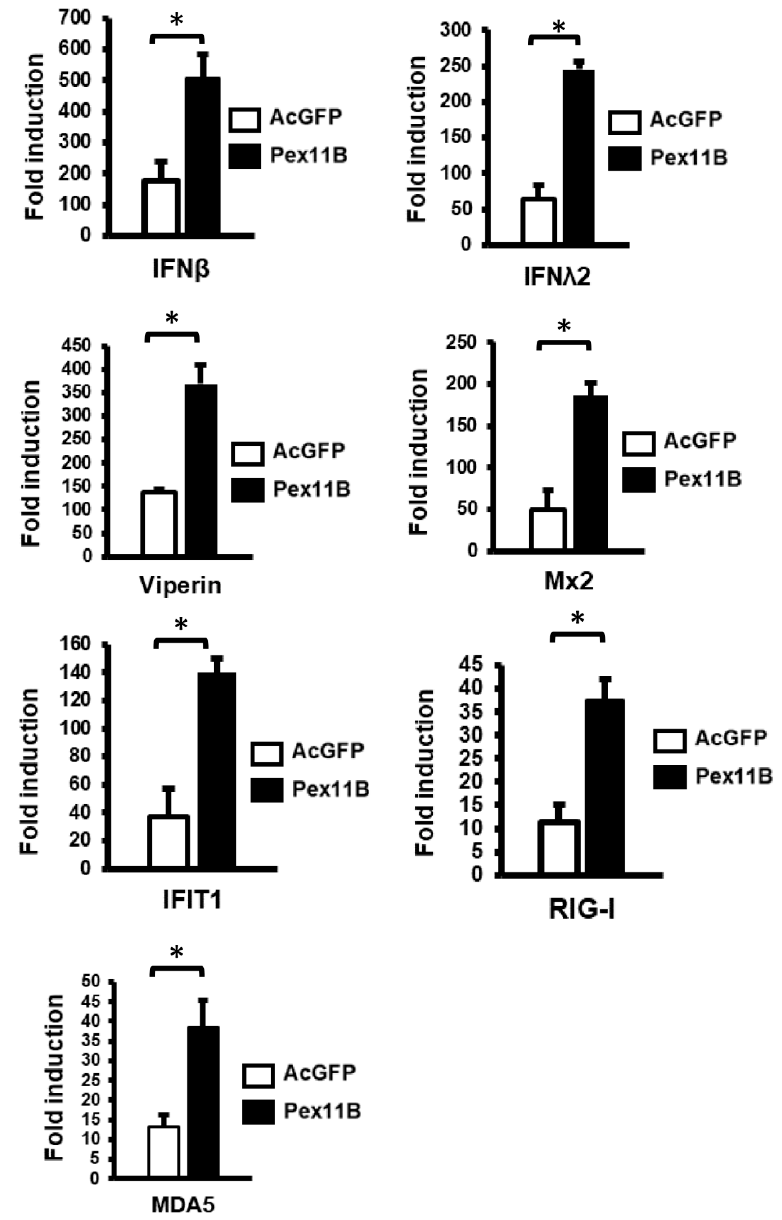
Figure 6. Over-expression of PEX11B enhances the innate immune response. U251 cells were transduced with lentiviruses encoding AcGFP alone or AcGFP plus myc-tagged PEX11B for 48 h and then transfected with poly(I:C) for 12 h. Cell lysates were processed for RNA extraction and subsequent qRT-PCR. Fold induction of selected ISG transcripts in response to poly(I:C) was determined. The mRNA levels of ISGs were normalized to ACT-B mRNA levels. The data represent the average from the results of three independent experiments. Bars represent standard error of the mean. * p < 0.05.